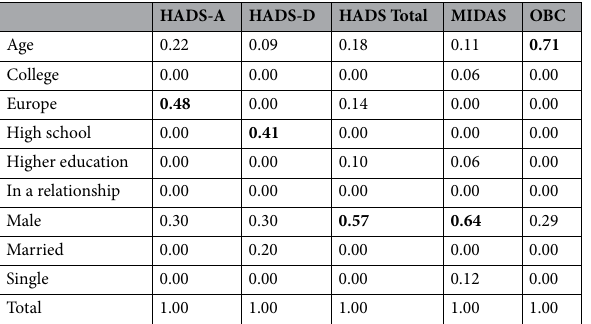
Table 5. Feature importance for each analyzed variable. The most informative (with highest impact on the analyzed value) features are indicated in bold. MIDAS—Migraine Disability Assessment, HADS—Hospital Anxiety and Depression Scale, OBC—Oral Behaviors